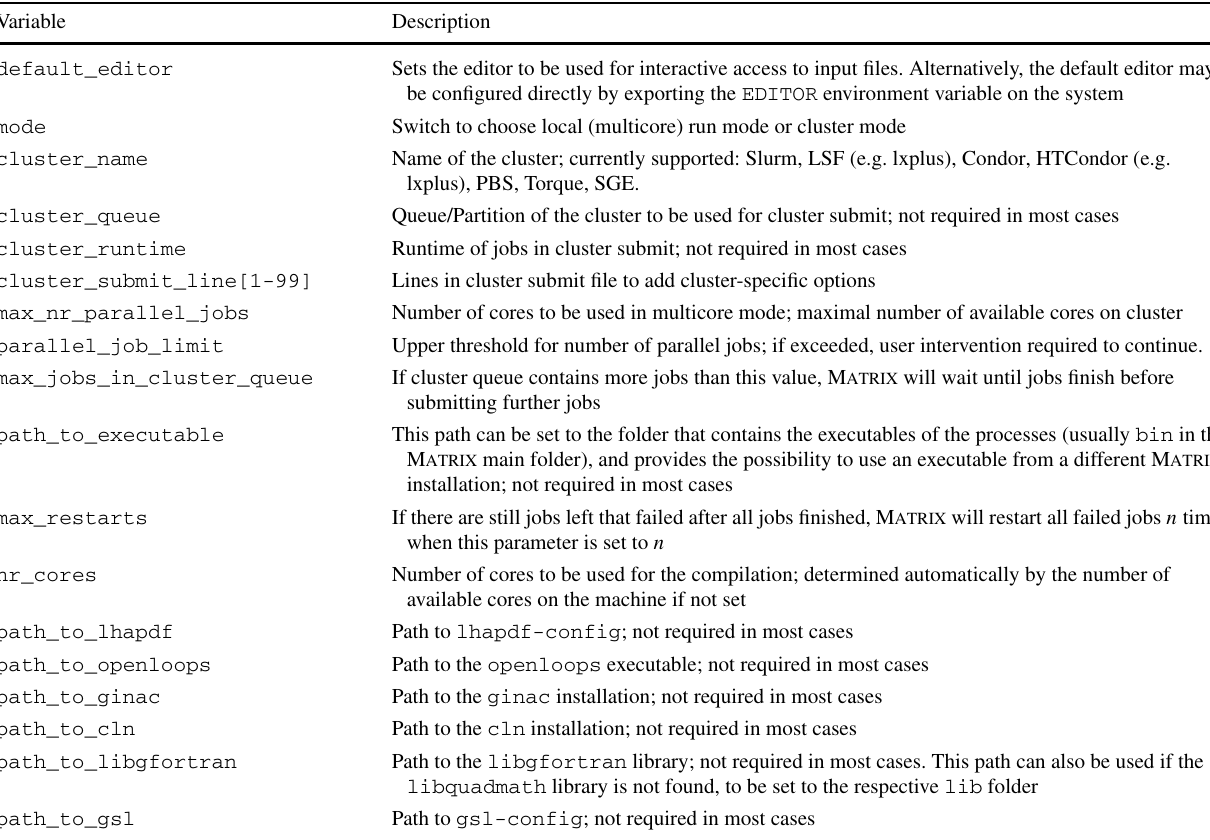
Table 2 Parameters to be set in the file MATRIX_configuration Variable